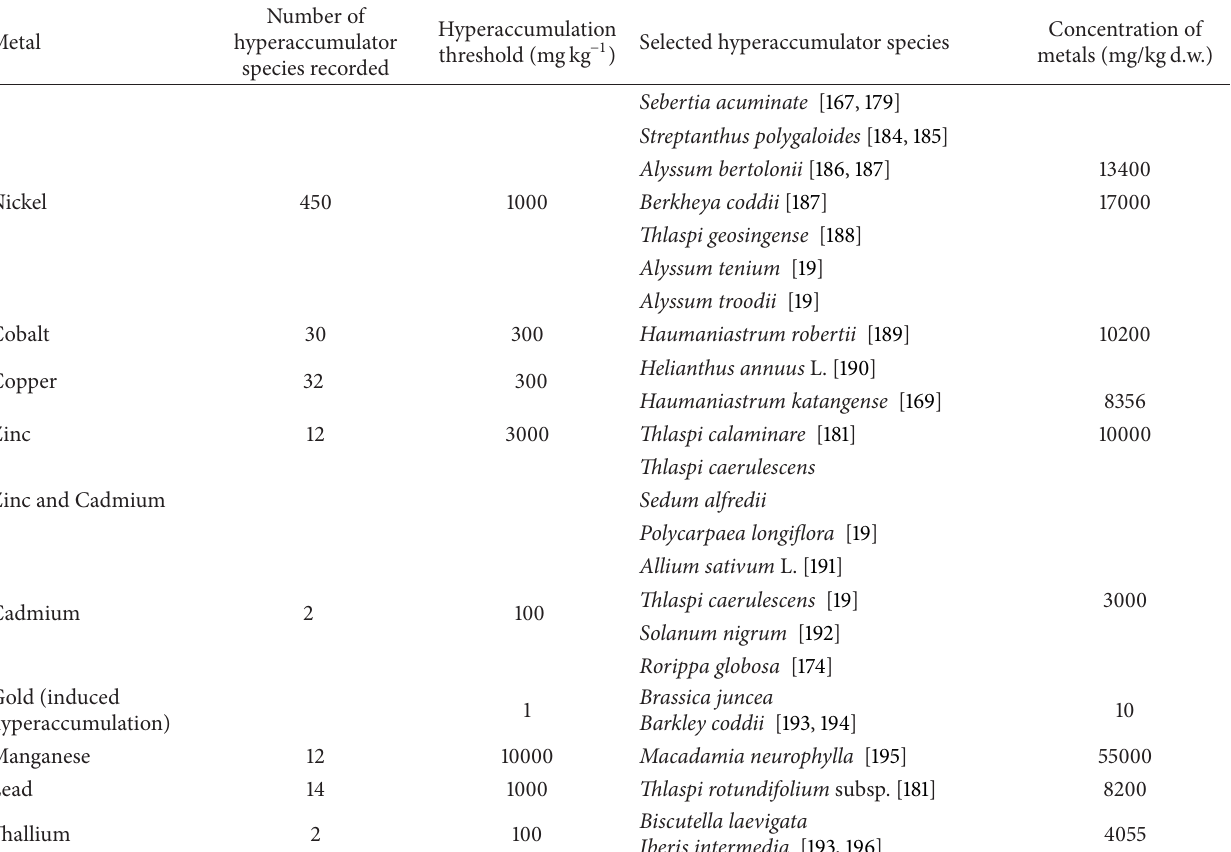
Table 5: Hyperaccumulators in phytomining. Source: van der Ent et al. [183] with modifications, together with the metal concentration in selected